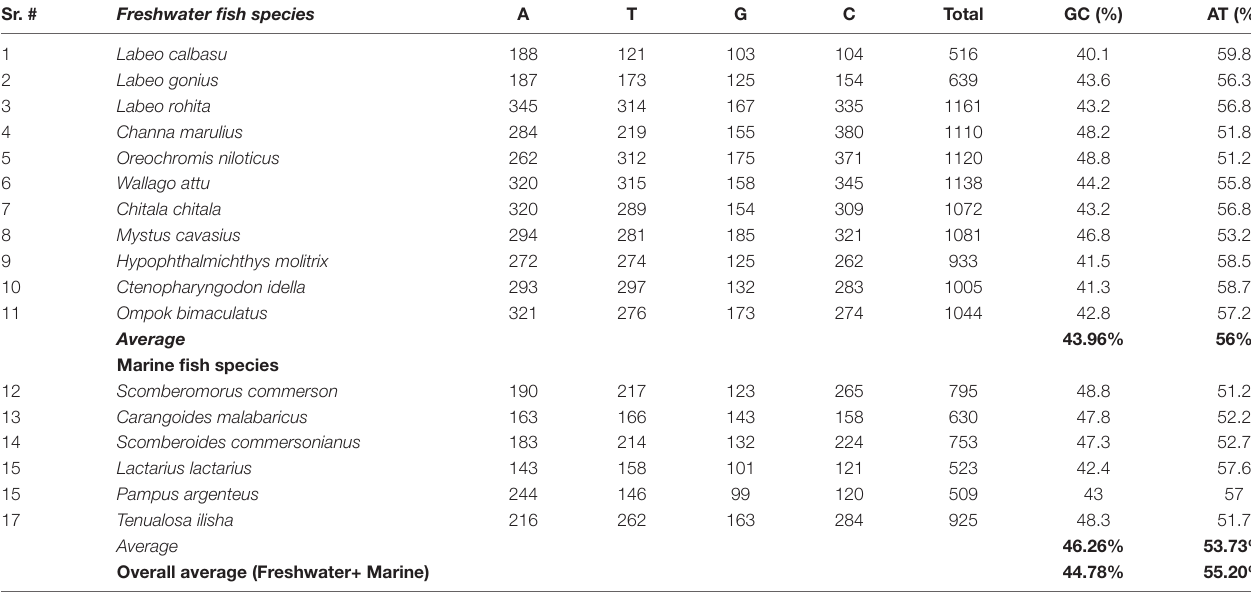
FIGURE 2 | Amplification of mitochondrial Cyt b gene. (M) represents the DNA ladder; lanes 1–11 are the freshwater fish species, lanes 12–17 are the marine fish species representing a gene amplification of 1,141 bp. TABLE 2 | Comparison of the average GC and AT nucleotide composition between freshwater and marine fish species. Sr.